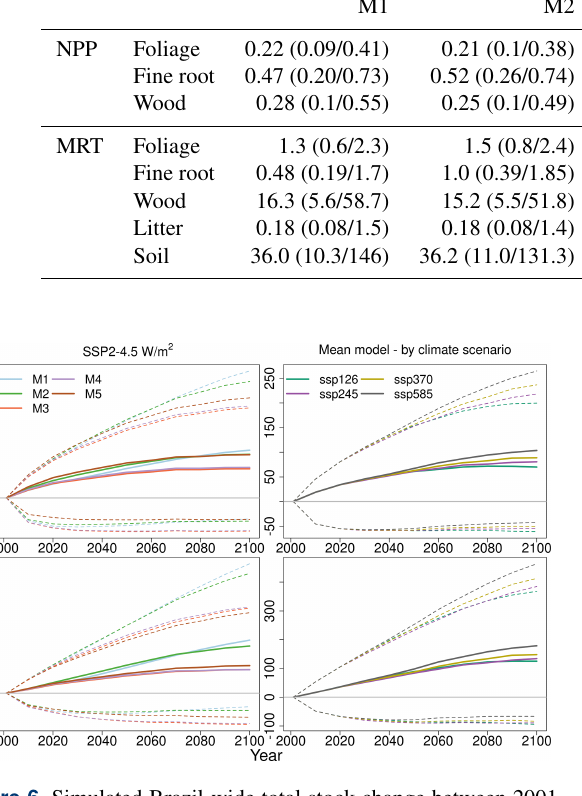
Figure 6. Simulated Brazil-wide total stock change between 2001 and 2100 for biomass (labile, foliar, fine root and wood) and dead organic matter (DOM; litter, wood litter (M5 only) and soil). The left column shows each model for the SSP2-4.5Wm − 2 climate sce- nario, while the right column shows the DALEC suite mean for each climate scenario. Median estimates are shown using a solid line, while the dashed lines indicate the 90% confidence interval. Note that uncertainties were propagated from the pixel level to Brazil- wide totals assuming fully correlated